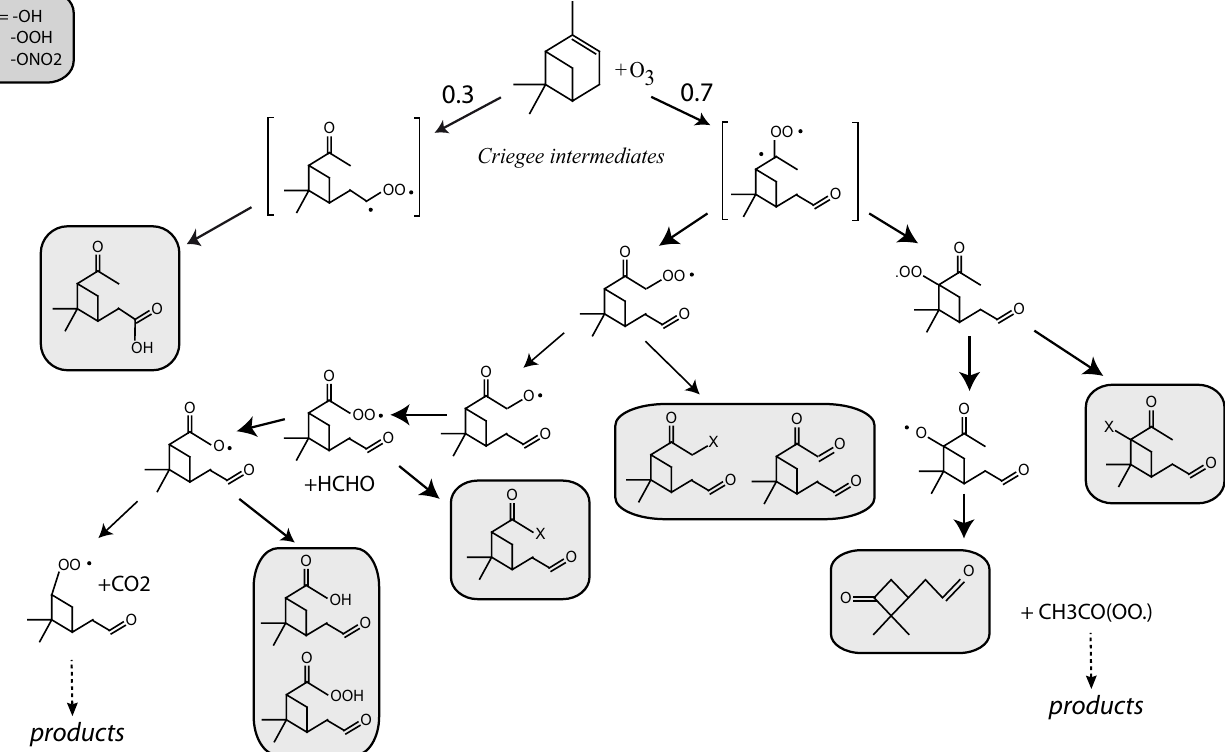
Fig. 3. First oxidation steps of the α -pinene oxidation by ozone as represented in GECKO-A. Framed compounds represent stable species.